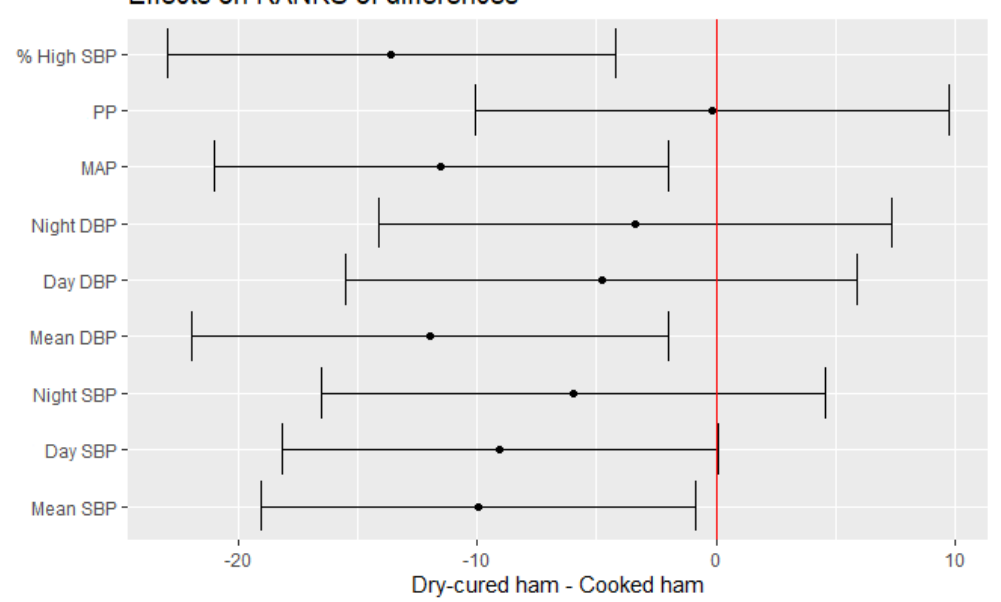
Figure 2. Estimate of the mean range of the effect of dry-cured ham intake minus placebo-controlled product and its 95% confidence intervals for blood pressure values.